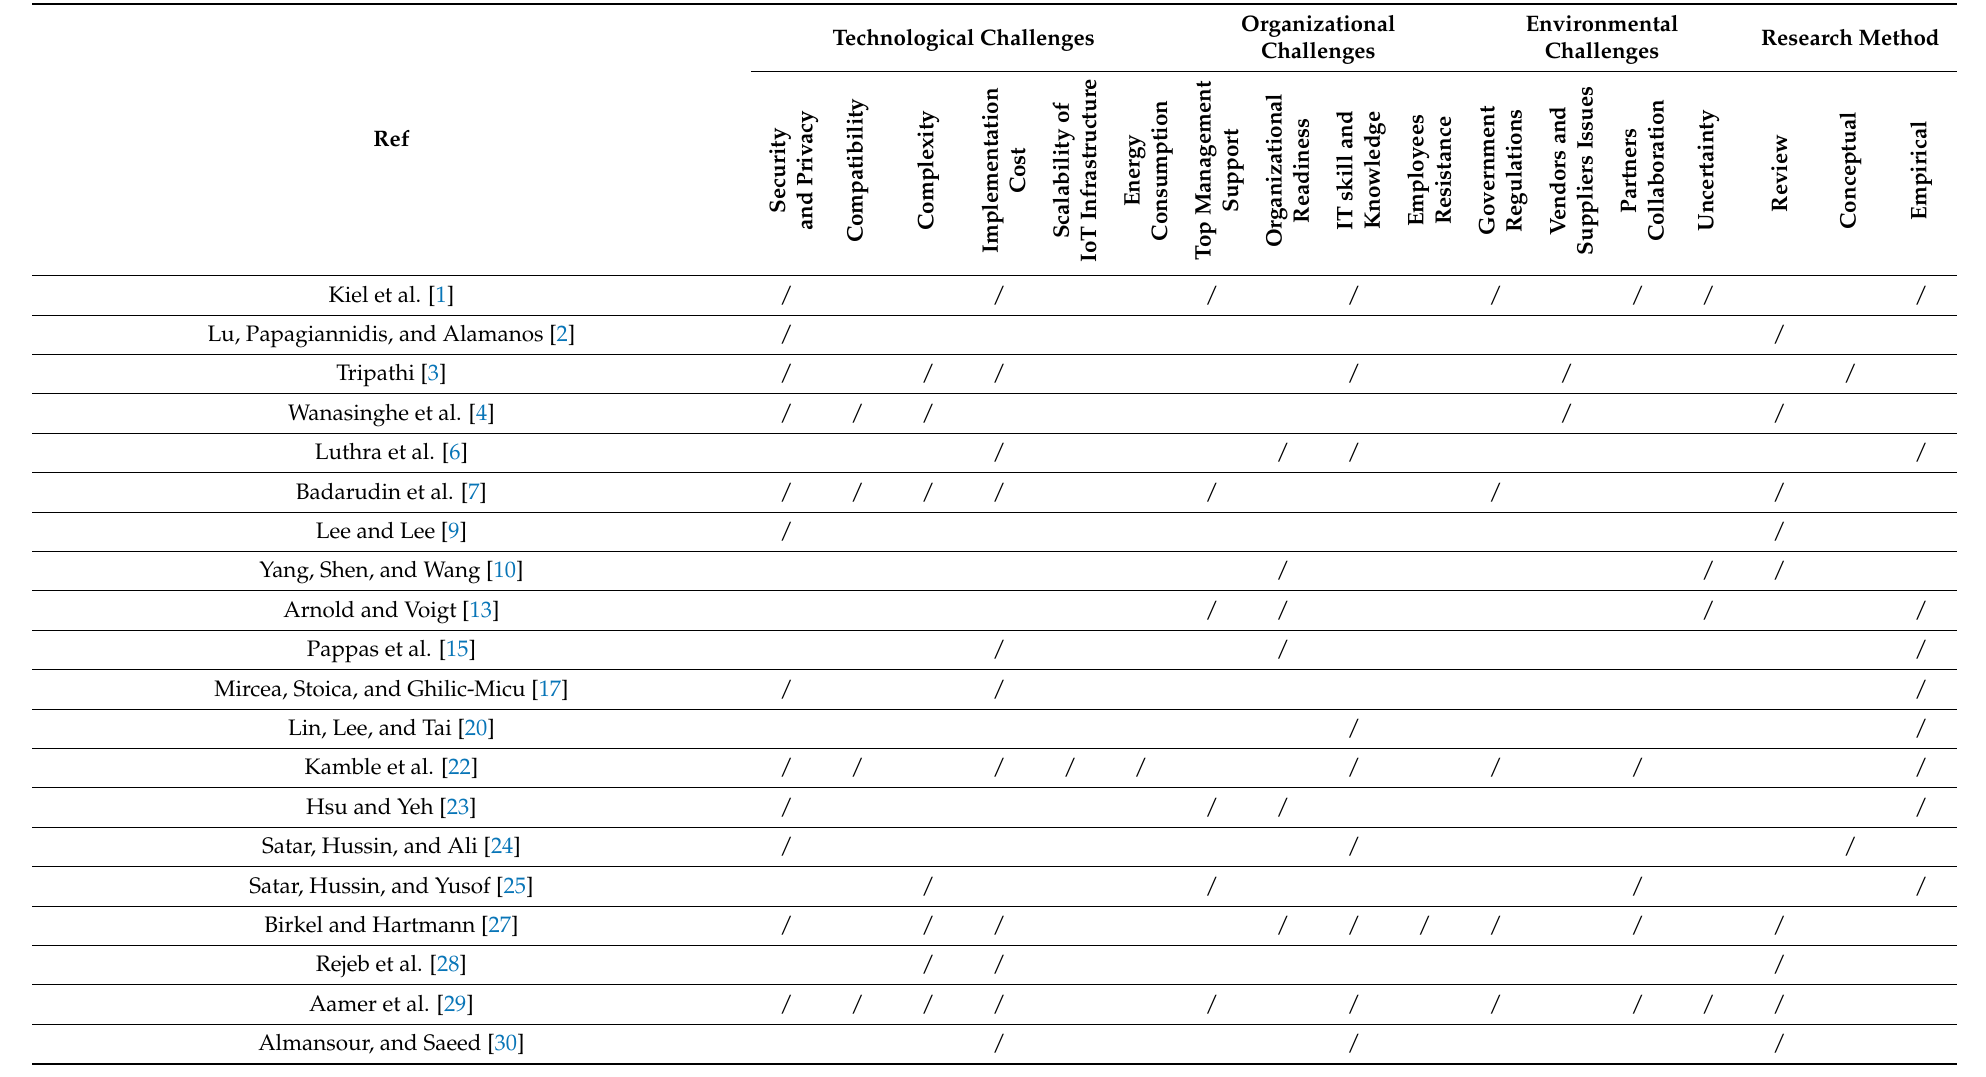
Table A3. Summary of IoT adoption